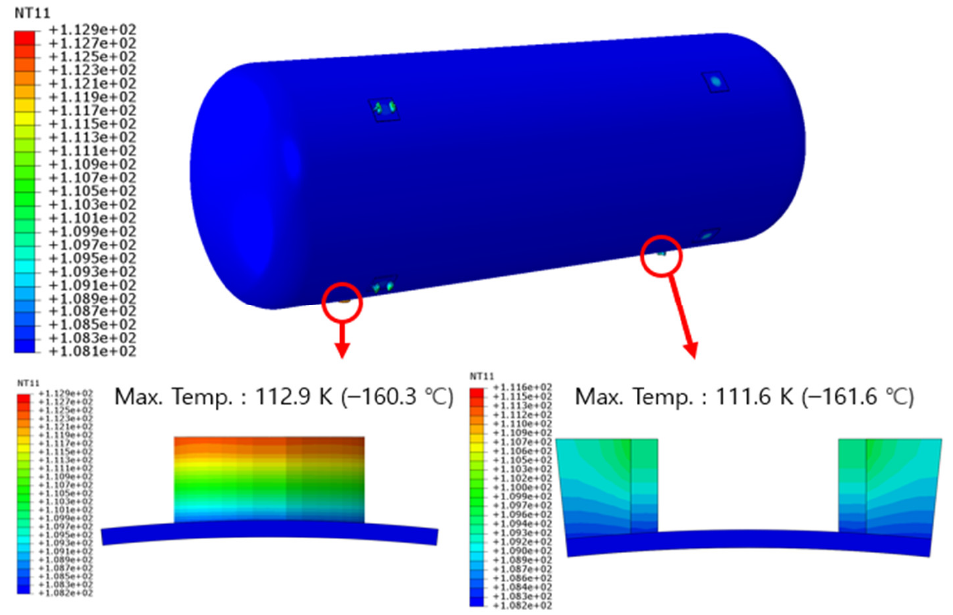
Figure 6. Temperature distribution of inner tank (SUS304).